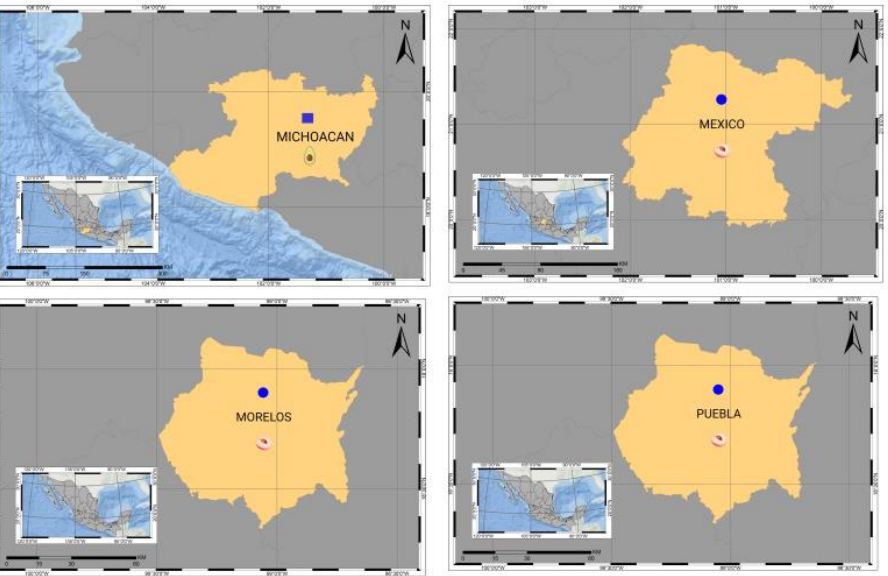
Figure 3. Distribution of viroids in Mexico associated with fruit-trees diseases. ASBVd-infected avocado trees in the state of Michoacan [17]. In the central region of Mexico, the presence of PLMVd was detected in peach orchards in the states of Puebla, Morelos, and Mexico [19].